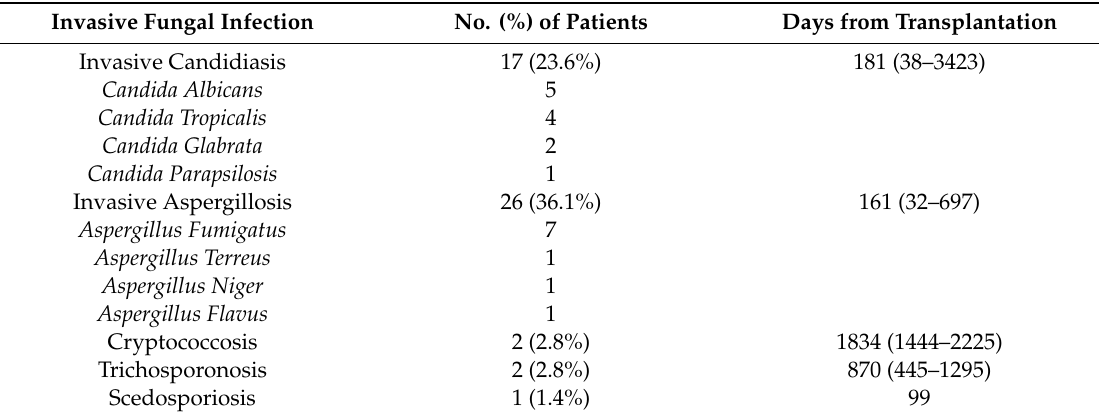
Table 3. Fungal pathogens causing invasive fungal disease.